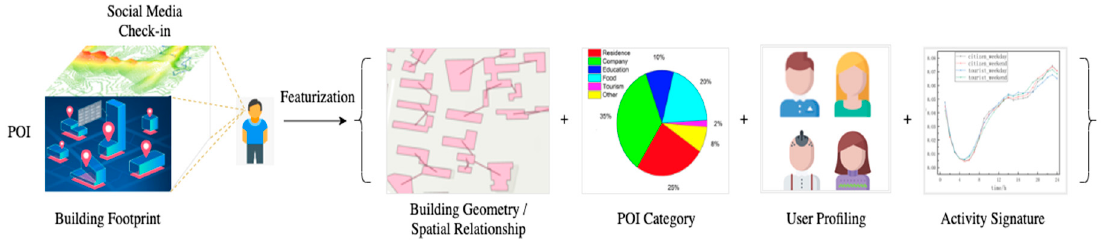
Figure 4. The model architecture of socioeconomic feature extraction.